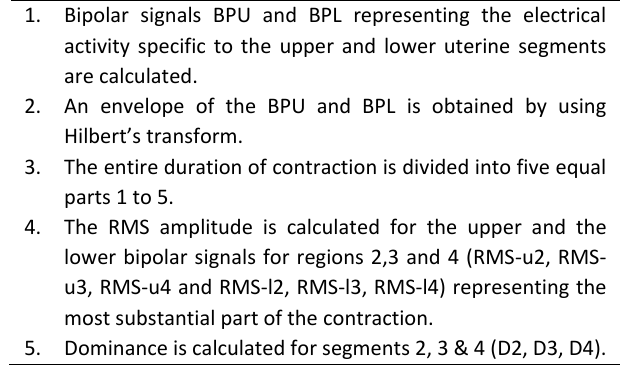
Table 3. The algorithm to calculate the dominant region of the